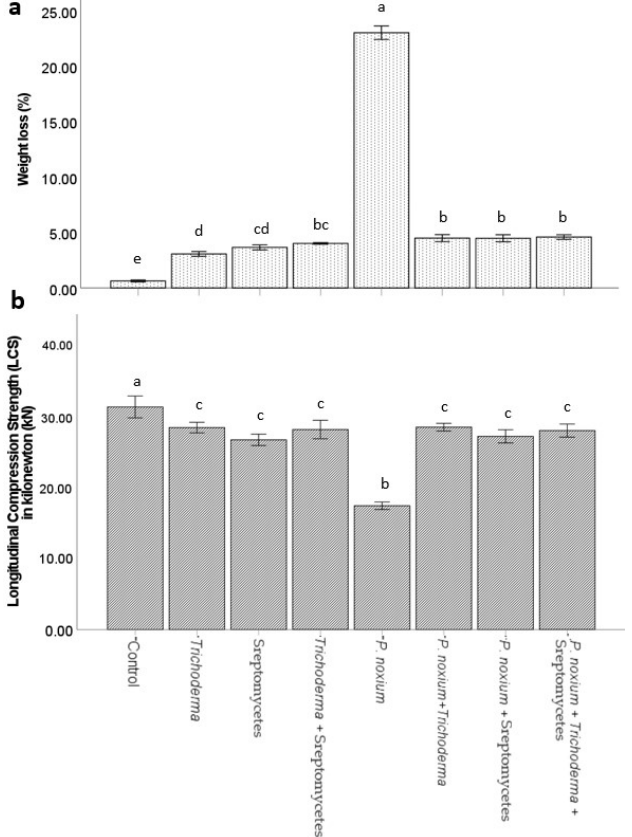
Figure 2. Inhibitory effects of biological control agents on P. noxium and subsequent prevention of wood decay ( a ) weight loss (%) and ( b ) wood strength. Footnote: Error bars represent standard error of the mean, and statistically significant ( p < 0.05) differences are noted by different letters (above the bars) according to Tukey’s test.